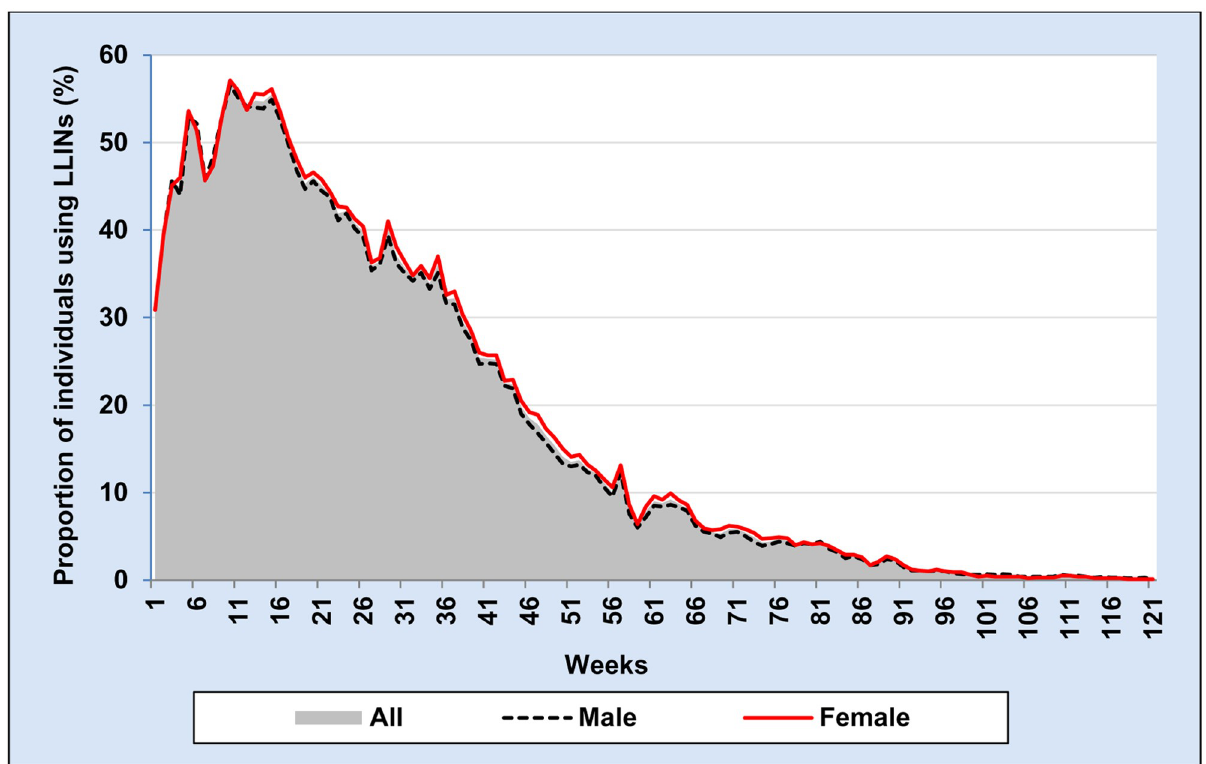
Fig 3. Weekly proportion of individuals using long-lasting insecticidal net by gender during 121 weeks from October 2014 to January 2017.